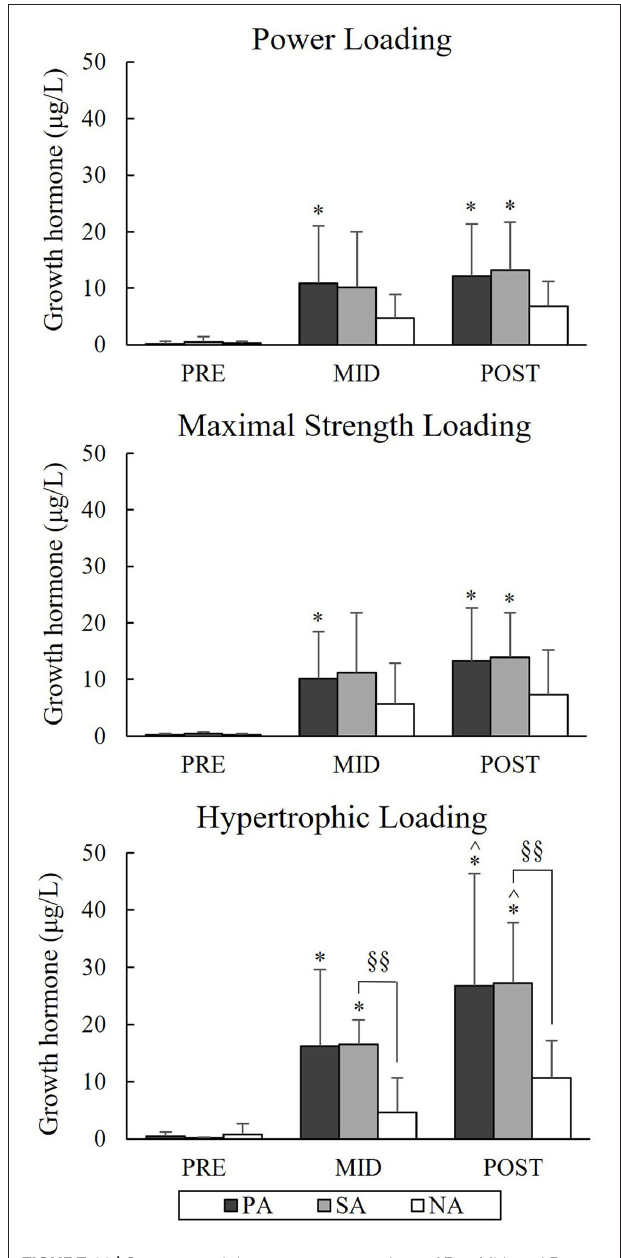
FIGURE 11 | Serum growth hormone concentrations of Pre, Mid, and Post during three resistance exercise loadings in power (PA), strength (SA), and non-athletes (NA). * p < 0.05 refer to within-group significances compared to Pre. ∧ p < 0.05 refer to within-group significances compared to Mid. §§ p < 0.01 refer to between-group